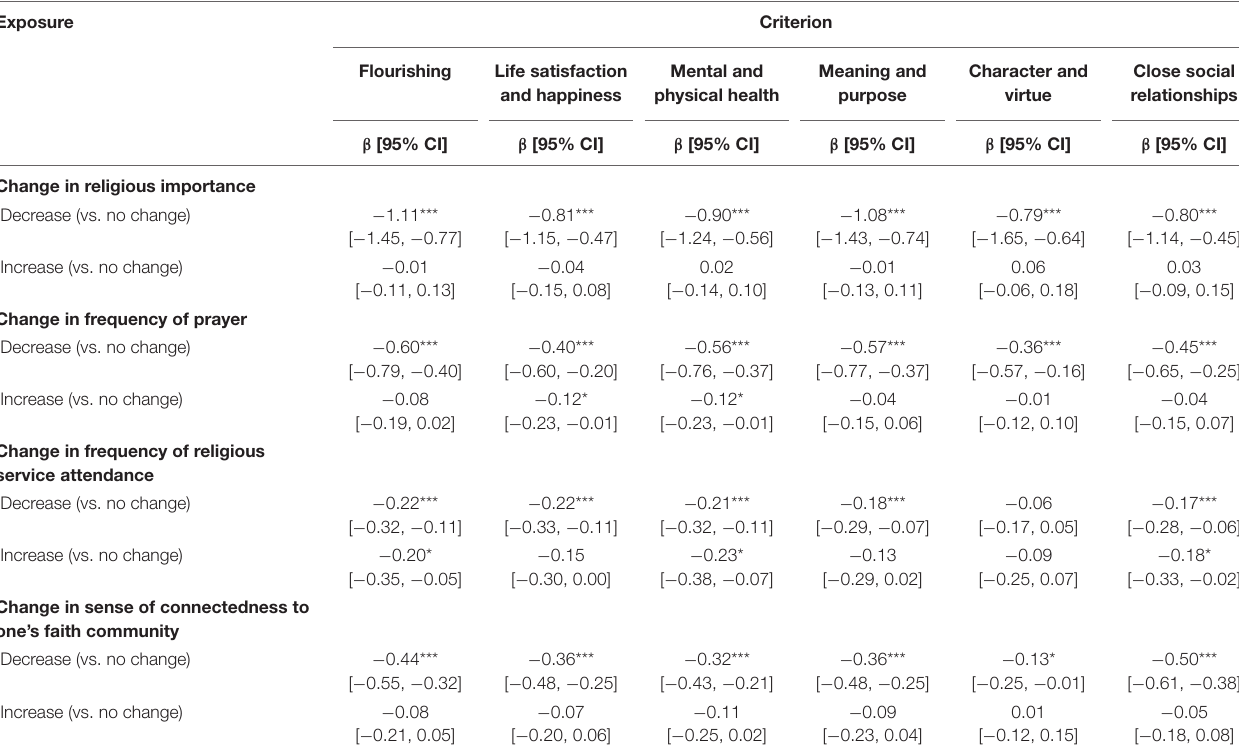
TABLE 2 | Linear multilevel regression models for associations of perceived changes in four dimensions of religiosity with flourishing and each of its domains ( N = 1,480). Exposure Criterion